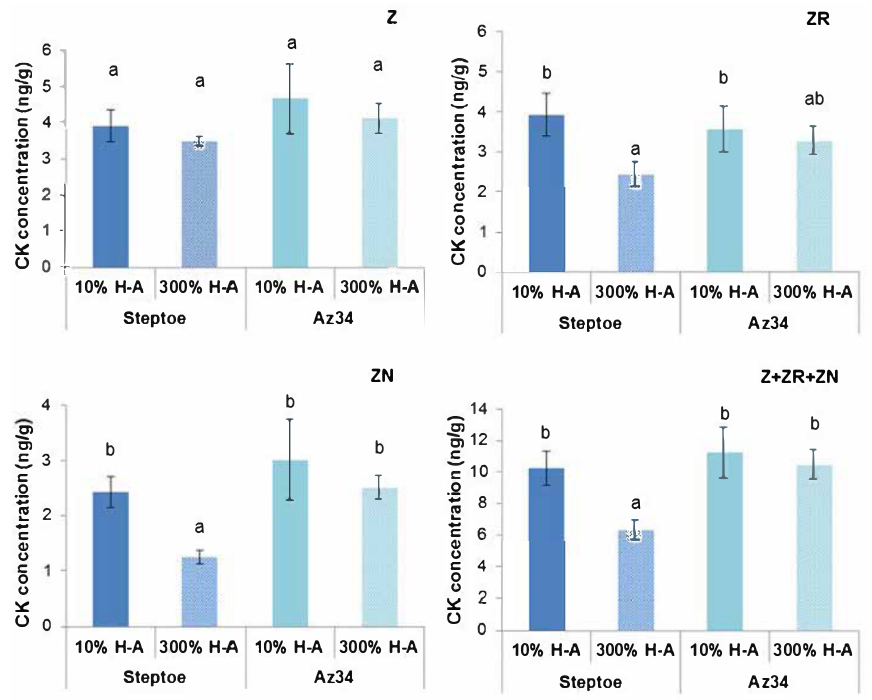
Figure 5. Concentration of zeatin (Z), zeatin riboside (ZR), zeatin nucleotide (ZN) and their sum (Z+ZR+ZN) in xylem exudate of 6-day-old barley wild type (Steptoe) and its ABA-deficient mutant (Az34) growing at 10% of supra-optimal (300%) Hoagland-Arnon solution (H-A). Means ± SE are presented. Statistically different means (n = 9) are indicated by different letters ( p < 0.05, ANOVA, Duncan’s test).